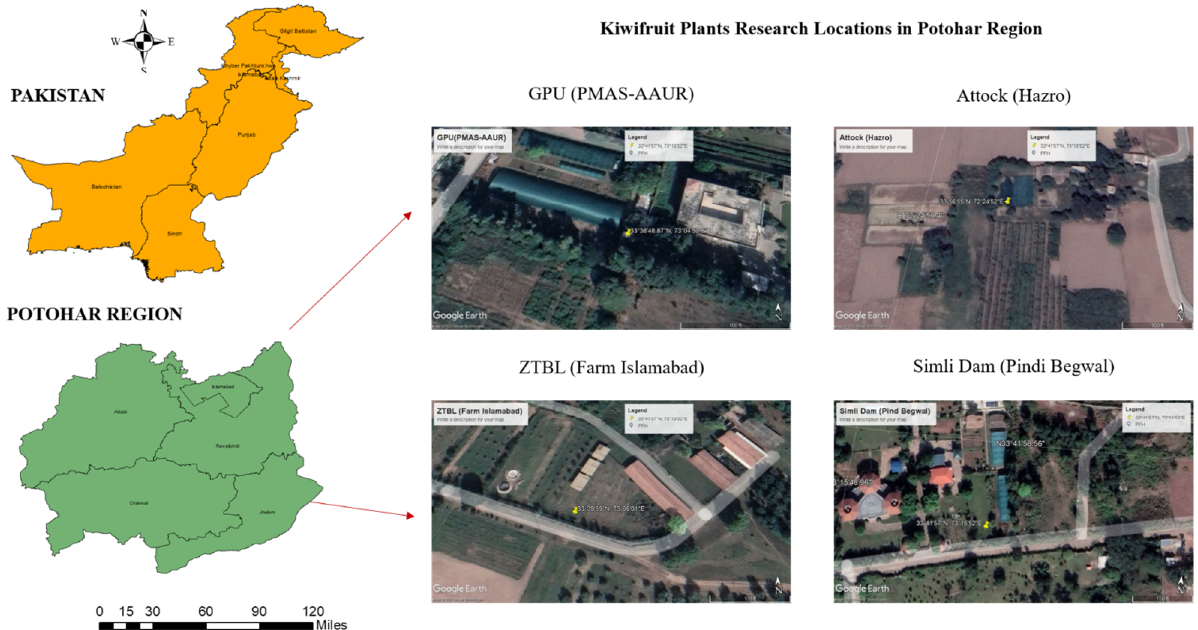
Figure 1. Kiwifruit plant research locations in Pothohar region .